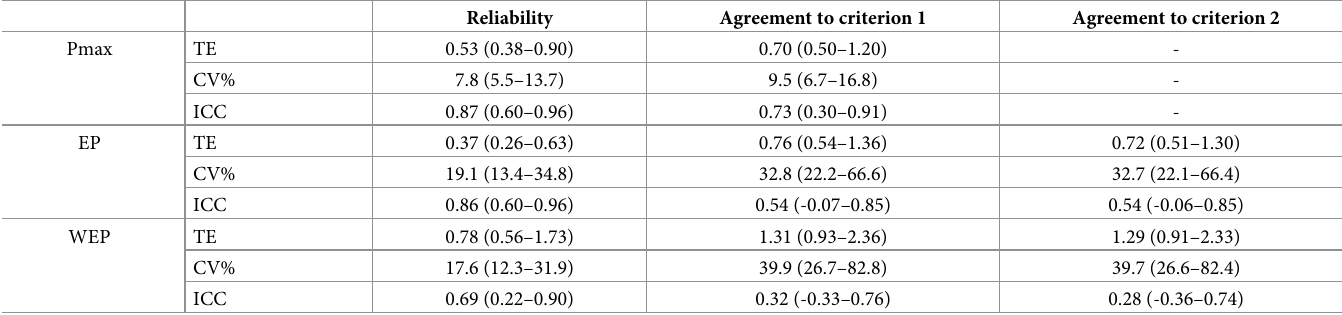
Table 1. Reliability analysis and comparison to criterion for power variables derived from AO3 (values in mean and